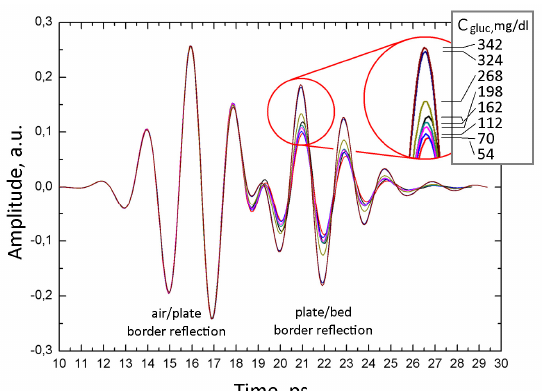
Fig. 5. Peak and peak-to-peak amplitude variations in re- flection from plate/bed border shows tendency to correlation with blood glucose